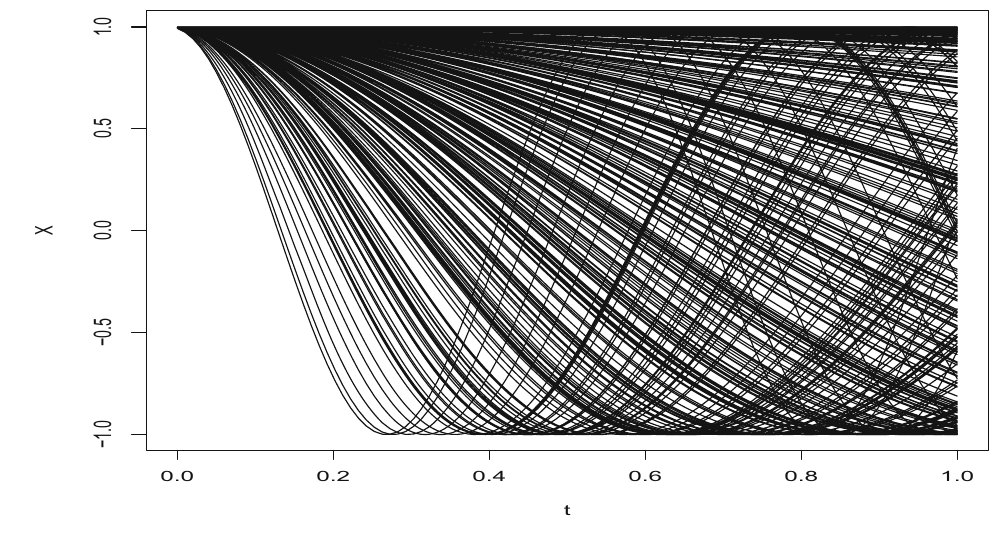
Fig. 1 A set of 300 simulated curves where W is generated from a Gaussian distribution N ( 0 , 1 ) and A is a random variable Bernoulli distributed s are generated from 300 curves and are plotted in Fig. 1. with parameter p = 0 . 5. X (cid:13) i On the other hand, n i.i.d. random variables ( C i ) i are simulated through the exponential distribution E (λ) and for i = 1 , . . . , n = 300 , , the scalar response Y i is computed by considering the following